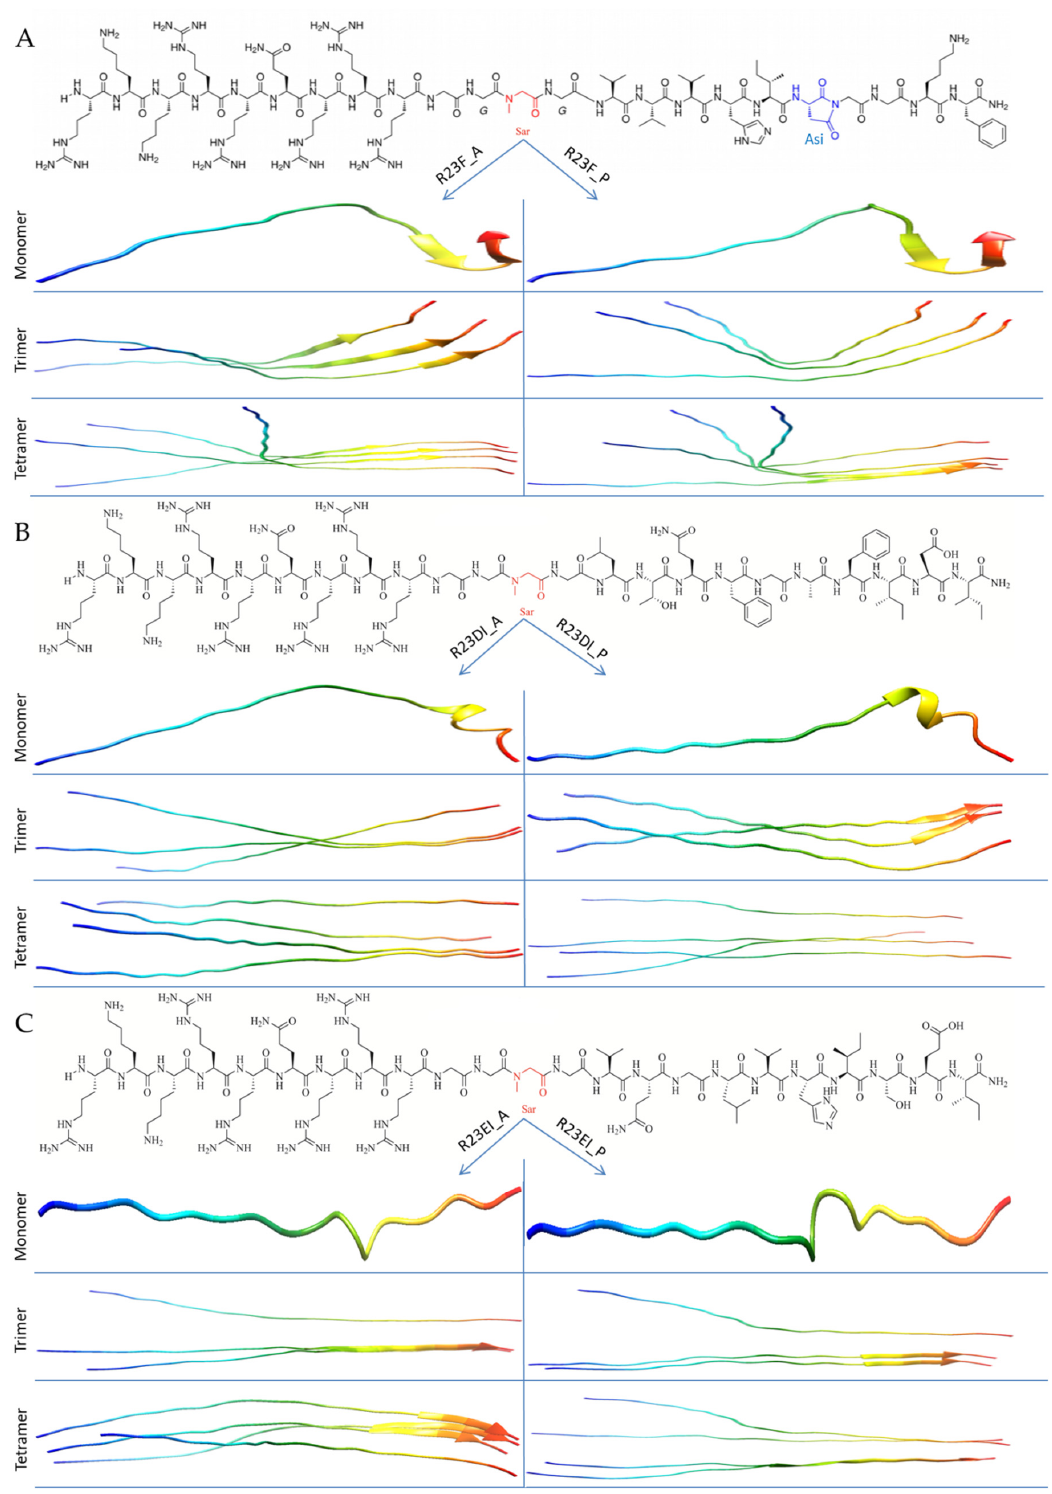
Figure 3. Primary structure and folding patterns of hybrid peptides R23F ( A ), R23DI ( B ), and R23EI ( C ) were predicted by AlphaFold 2. In the primary structure of the R23F peptide, a modified asparagine residue (aminosuccinimide, Asi) is shown in blue, and sarcosine residues (Sar) are shown in red for the three peptides. To model the structure of peptides using AlphaFold 2, sarcosine residues were replaced with alanine (A) or proline (P) residues in the left and right portions of the figure correspondently